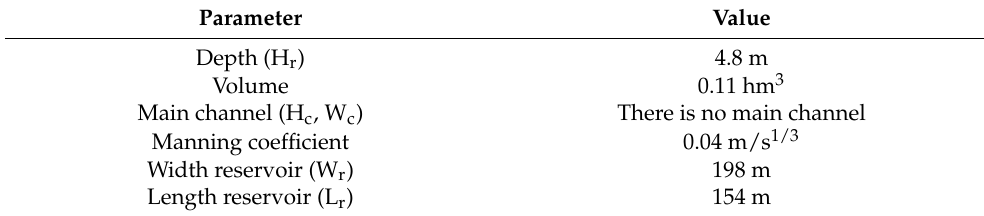
Table 6. Characteristics El Rubial off-stream reservoir.